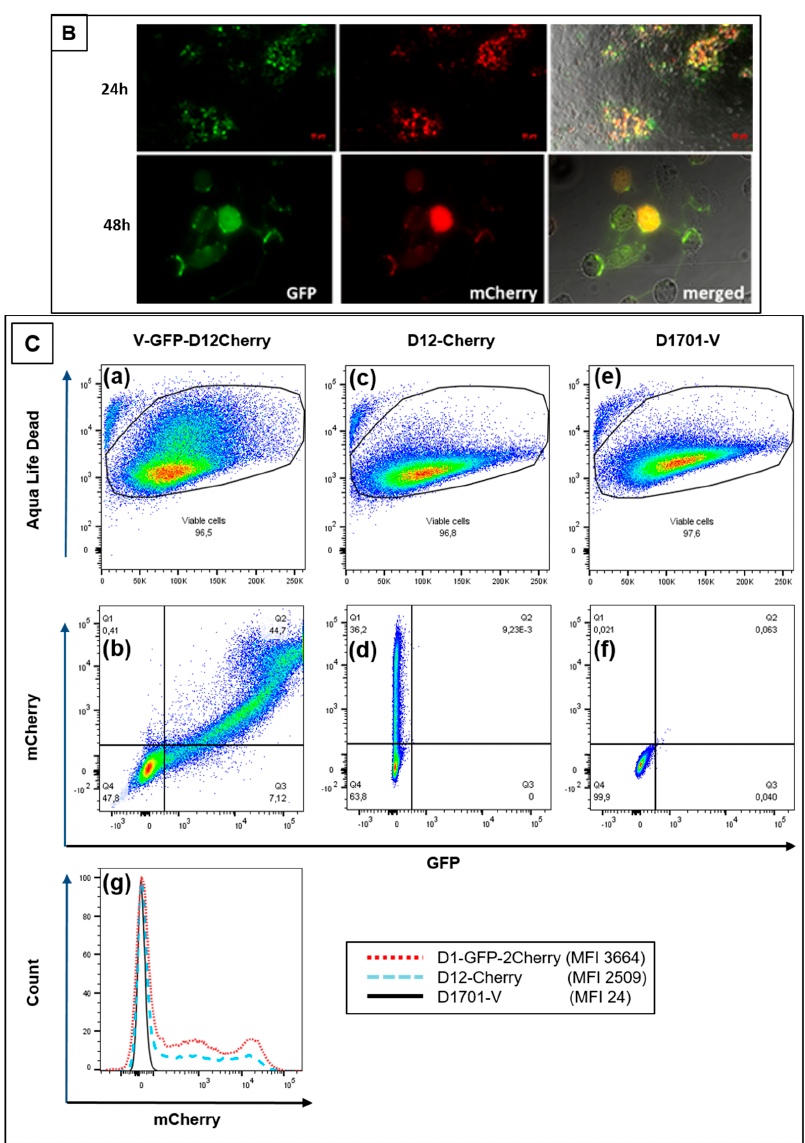
Figure 6. ( A ) PCR to demonstrate correct insertion of AcGFP in the V locus and mCherry in locus D. ( a ) The map location of primers is depicted, the homology arms vegf-L and vegf-R as well as Del2-F and Del2-R, the early promoters Pv, ep1 and eP2 are schematically drawn. ( b ) The results of the PCR with the indicated primer combinations are separated in 0.8% agarose gels with templates isolated from ( lanes 1 ) V-GFP-D12-Cherry infected cells, ( lanes 2 ) V-gfp infected cells, ( lanes 3 ) non-infected cells and ( lanes 4 ) non-template reaction. The amplicon sizes are indicated in kbp, DNA size markers are separated in lanes M1 (100 bp ladder) and lane M2 (1 kbp ladder). ( B ) Confocal images showing plaque formation of Vero cells 24 and 48 hours after infection with moi 2.0 of D1701-V-AcGFP-D12-mCherry (V-GFP-D12-Cherry). Concurrent expression of AcGFP (green) and mCherry (red) are demonstrated in each infected cell (merged). Microscopic magnification 10 × (24 h) and 20 × (48 h). ( C ) Flow cytometric determination of viability (Aqua Life Dead) and fluorescent protein expression 24 hours after infection (moi of 2.0) with V-GFP-D12-Cherry ( a,b ), with D12-Cherry ( c,d ) and as a negative control with D1701-V ( e,f ). The dot plots (b), (d) and (f) show on X -axis the number of AcGFP-positive cells and on Y-axis the number of mCherry-positive cells. The overlay of the mCherry histograms of (b), (d) and (f) is plotted in ( g ) for direct comparing the number of mCherry-positive cells; the mCherry mean fluorescence intensity (MFI) is given for each virus-infected cells in the